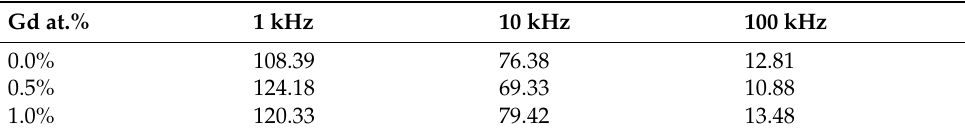
Table 7. Dynamic magnetic performances of µ e